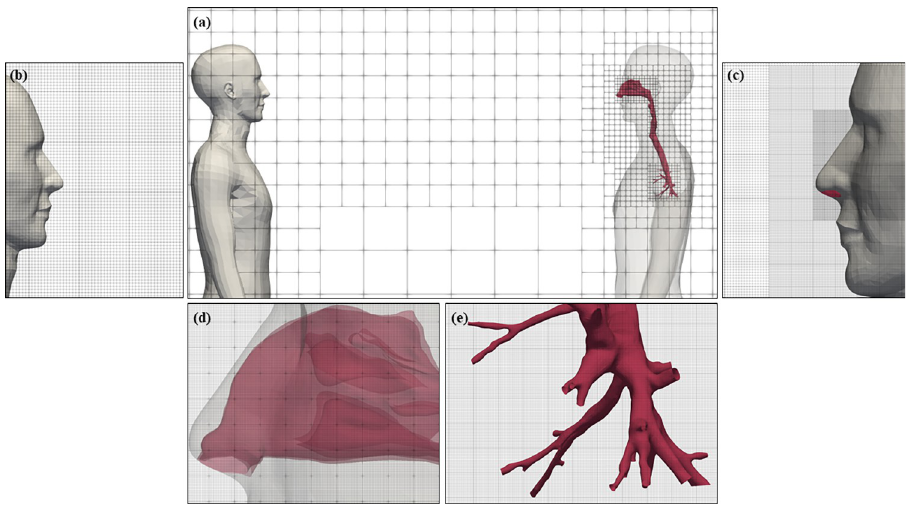
Fig 2. BCM mesh design (a) between Human 1 and Human 2, (b) near the mouth of Human 1, (c) around the nose of Human 2, (d) inside the nasal cavity and vestibule and (e) inside the bronchial